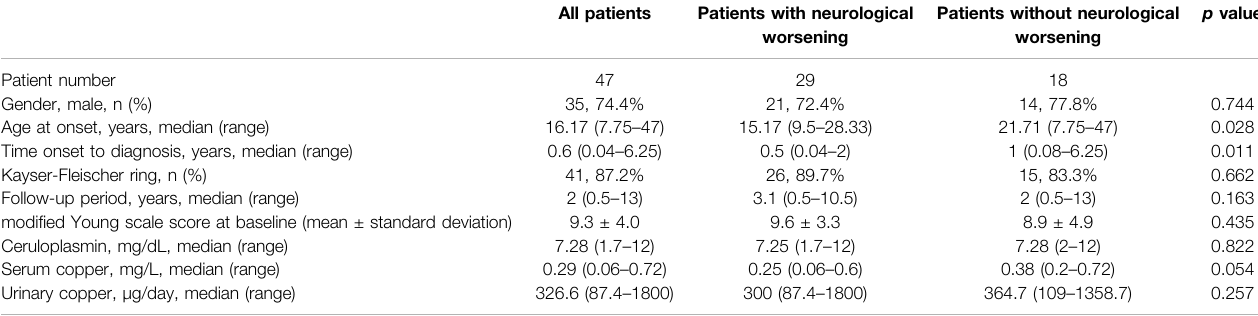
TABLE 1 | Clinical and laboratory characteristics at the time of diagnosis in 47 neurological WD patients and comparisons between patients with and without neurological worsening.